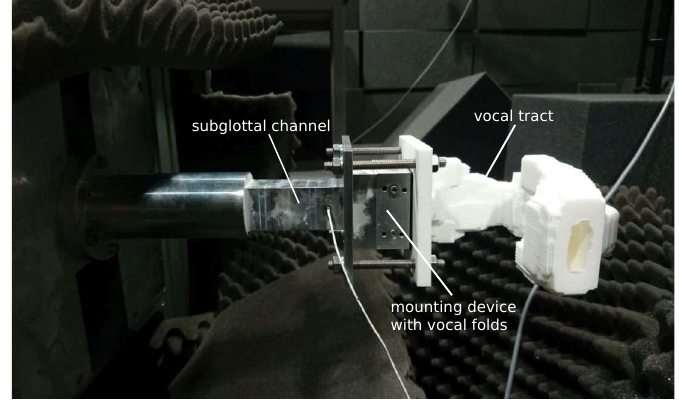
Figure 4. Experimental setup with subglottal channel, synthetic vocal folds and realistic VT